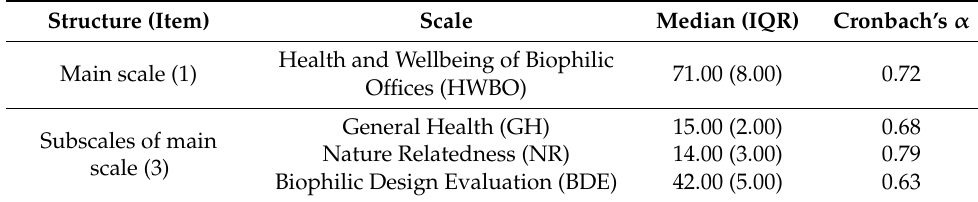
Table 8. Medians, interquartile range (IQR), and α coefficient values of workers’ evaluation based on HWBO, GH, NR, and